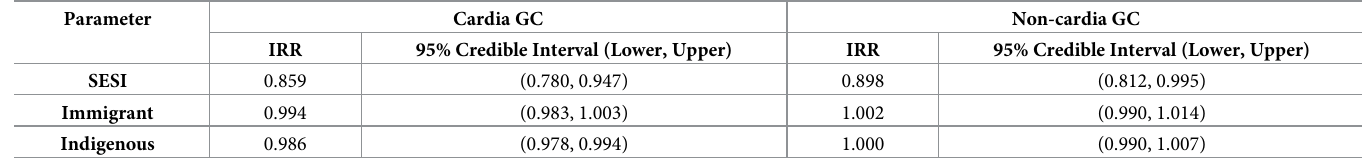
Table 3. Incidence Risk Ratio (IRR) and 95% credible interval for cardia and non-cardia GC dataset using spatial Poisson regression model. Parameter